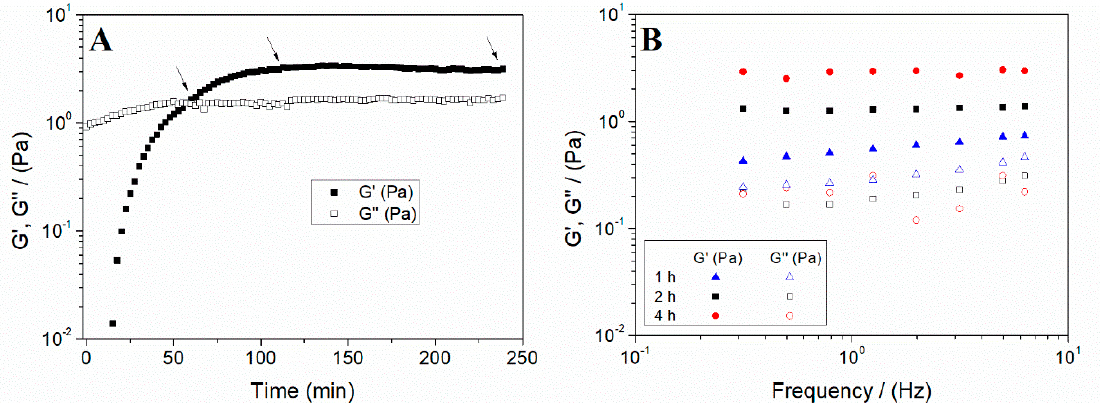
Figure 3. ( A ) Time sweep test of a collagen hydrogel (the arrows included indicate the gelation times selected for the further study) and ( B ) evolution of the elastic and viscous moduli (G’ and G’’, respectively) of the collagen hydrogels processed at different gelation times (1, 2 and 4 h).